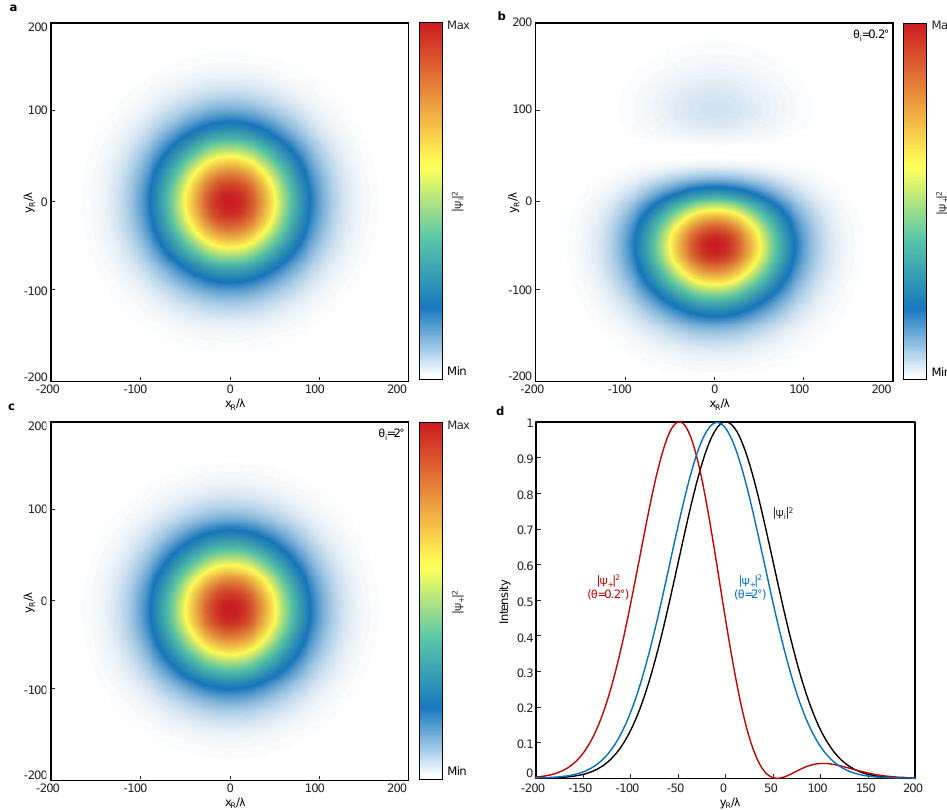
Figure 5. Intensity profiles of the incident and reflected beams. ( a ) 2D intensity profiles of the incident beam. ( b , c ) Intensity profiles of the reflected LCP beams at a plane perpendicular to the propagation direction at ( b ) θ i = 0.2 ◦ and ( c ) θ i = 2 ◦ . ( d ) 1D intensity profile at x R =